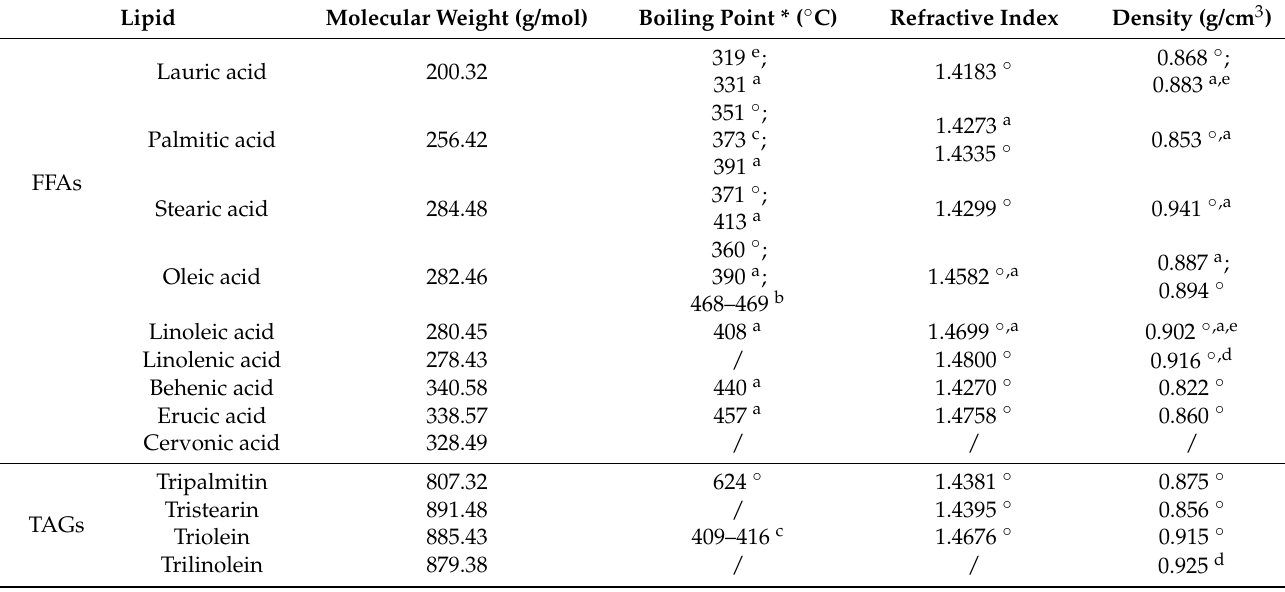
Table 1. Molecular weights and physical properties of free fatty acids (FFAs) and triacylglycerols (TAGs) retrieved from the CRC Handbook of Chemistry and Physics [59] and ChemSpider [60]. ChemSpider is an online structure database providing search access to hundreds of data sources. The original sources of data collection are indicated with a superscript letter.